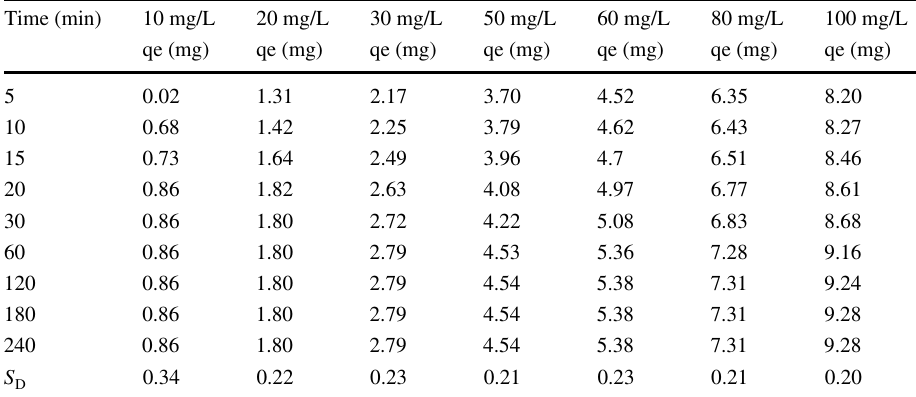
Table 7 Observed frequencies on the effect of time (min) and concentration (mg/L) for the Cr(VI) ion equilibrium adsorption capacity (qe)